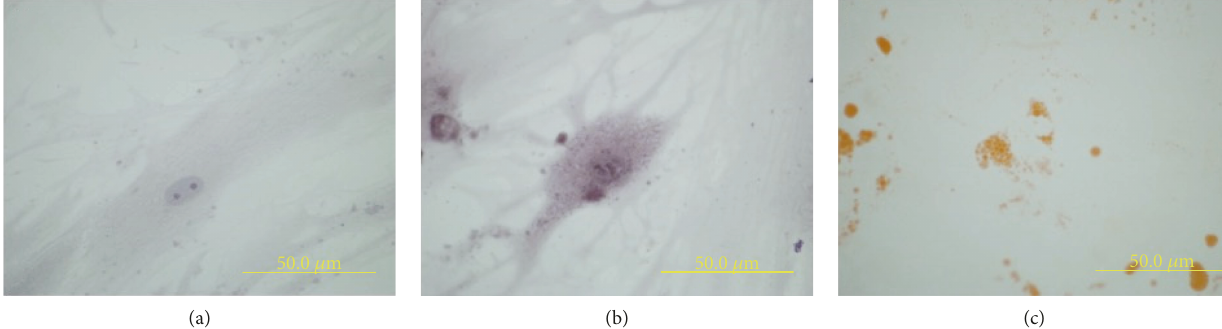
Figure 3: In vitro multilineage di ff erentiation of hMSC: (a) control, (b) osteoblastic di ff erentiation, and (c) adipocytic di ff erentiation (scale bar: 50 μ m).